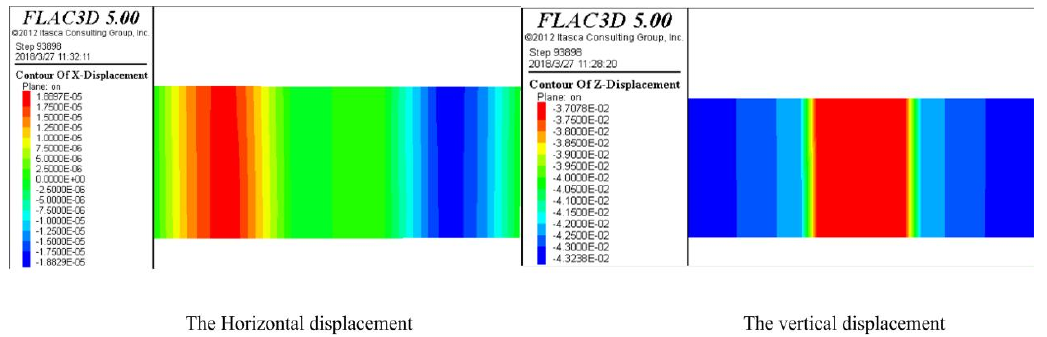
Figure 13. The axial force at the top and the bottom of the conical head vs. D / d.